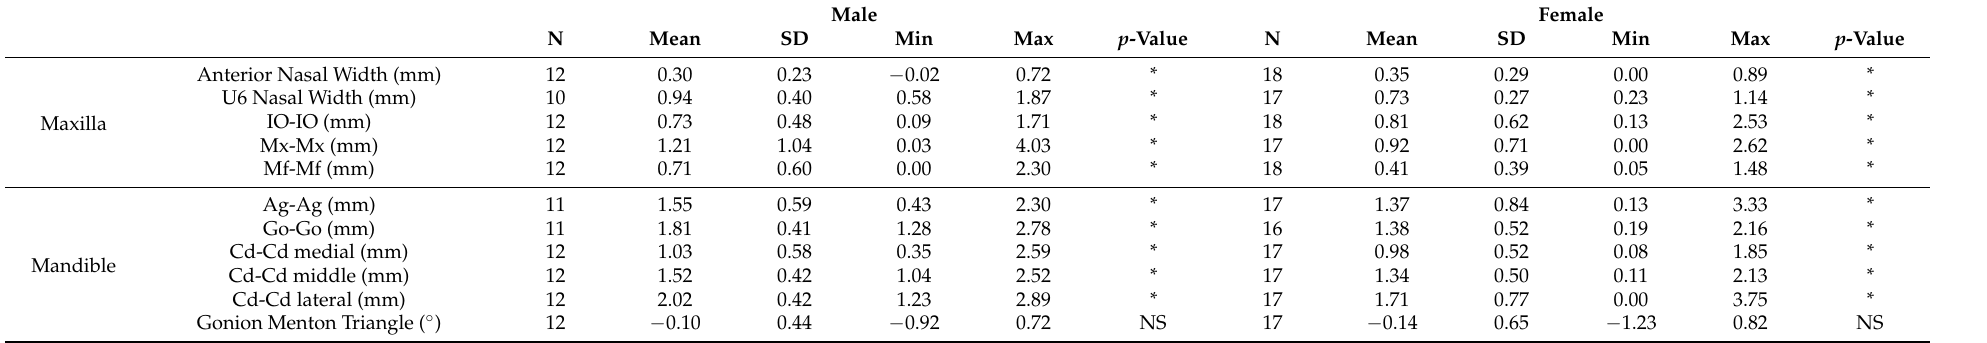
Table 1. Skeletal Transverse Changes Per Year in Males and Females (non-tooth-bearing regions) ( * , p < 0.05; NS, not